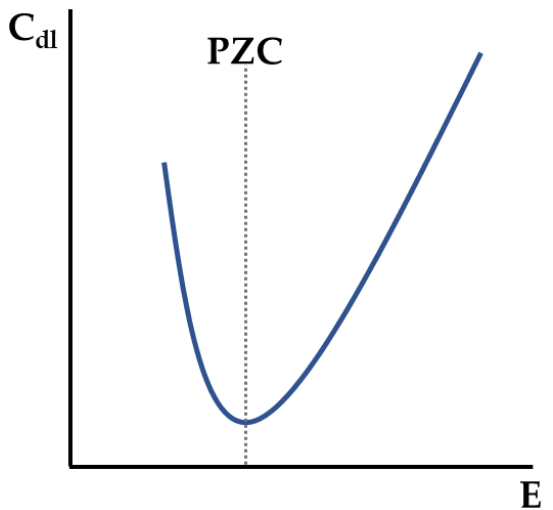
Figure 4. Representation of the double layer capacitance ( C dl ) variation with potential (E). The minimum is marked with a gray dotted line, representing the potential of zero charge (PZC).